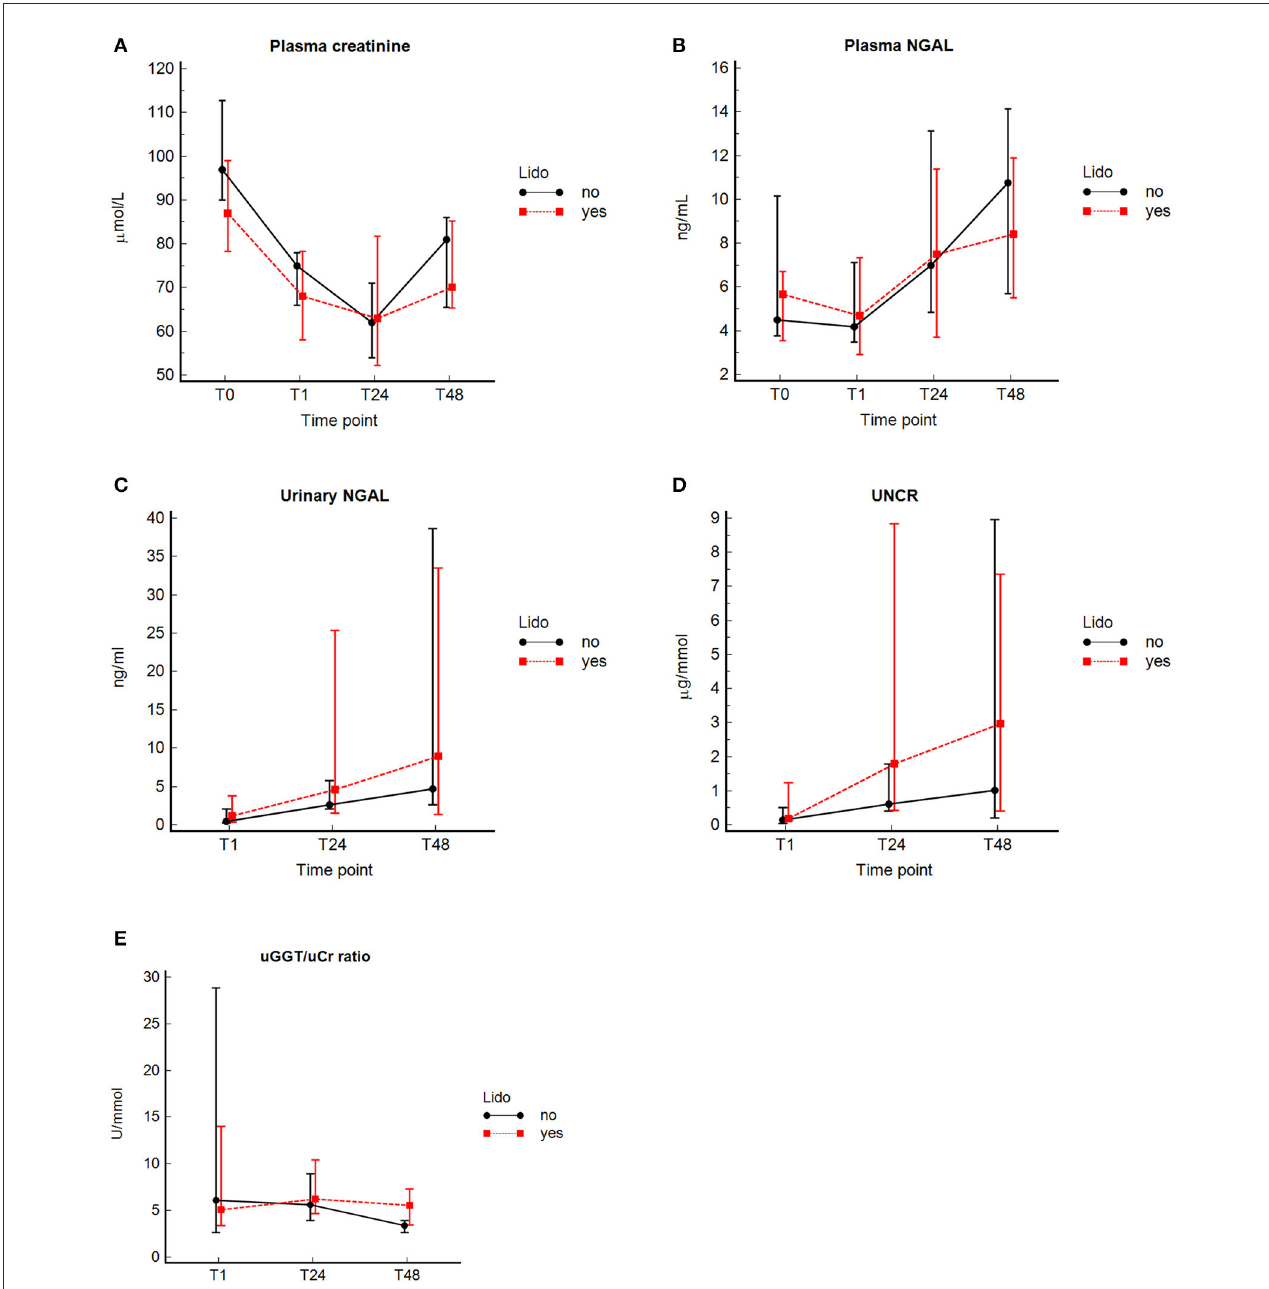
FIGURE2 Concentrations (median and interquartile range) of pCr, pNGAL, uNGAL, uGGT/uCr, and UNCR at the different time points in 32 dogs with GDV with and without lidocaine. Median (central value marker-dot) and interquartile range (error bars) of concentrations of plasma creatinine (pCr) (A) , plasmatic neutrophil gelatinase-associated lipocalin (pNGAL) (B) , urinary NGAL (uNGAL) (C) , uNGAL to urine creatinine ratio (UNCR) (D) , and urinary gamma-glutamyl transferase to urine creatinine ratio (GGT/uCr) (E) in dogs with lidocaine and without lidocaine; T 0 , at admission (prior any therapeutic intervention); T 1 , immediately after surgery (plasma marker), or during surgery by cystocentesis or immediately after surgery by urinary catheterization (urine marker); and at 24 ± 4 ( T 24 ), and 48 ± 4h ( T 48 )